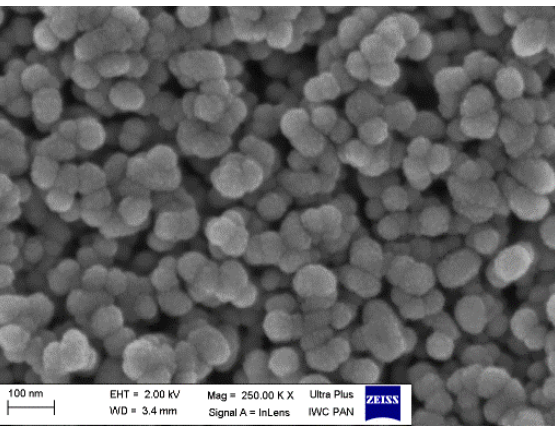
Figure 1. ZnO nanoparticles as visualized using